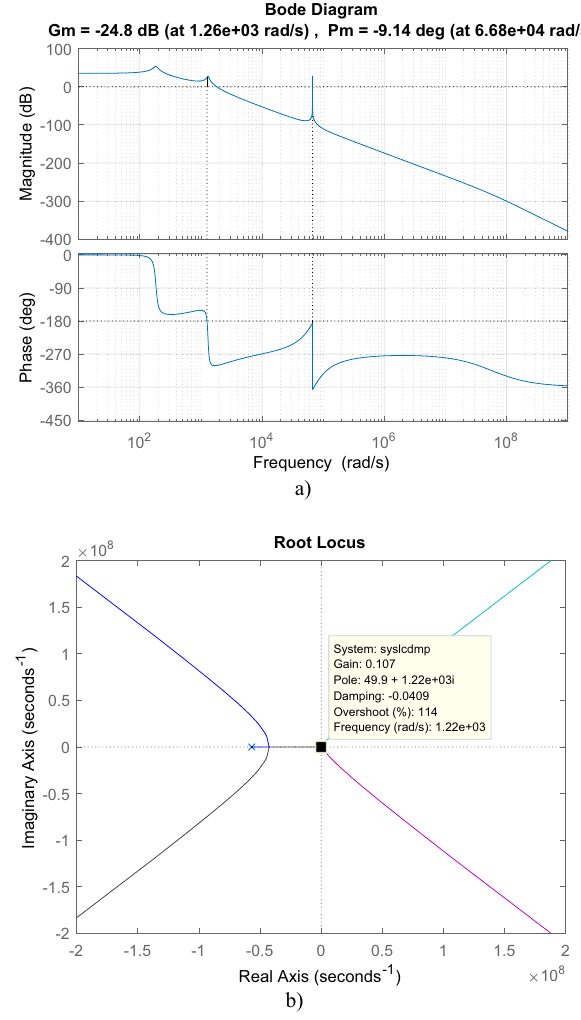
Figure 14. For LC with damping DM filter with isolated Ćuk PFC, ( a ) Bode diagram, ( b ) root locus.